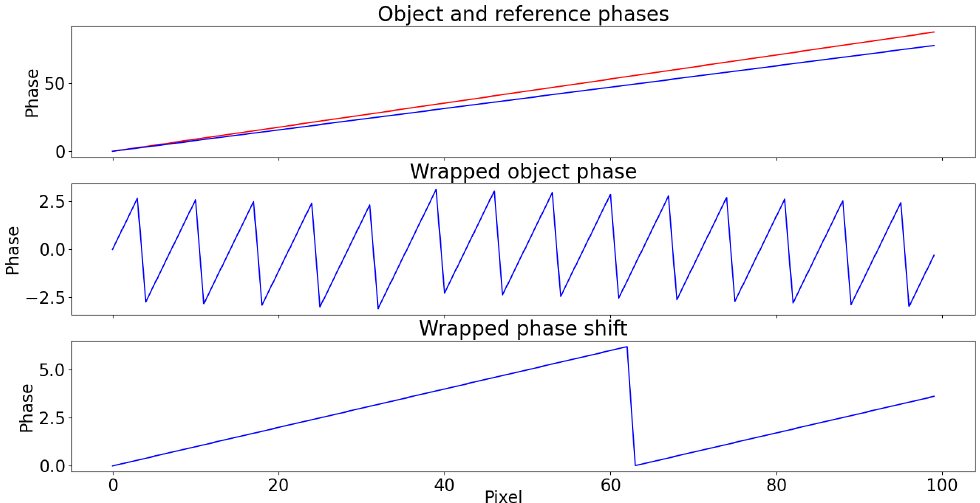
Figure 5. ( Top ) Illustrative reference Φ 0 (blue) and object Φ (red) phases. ( Middle ) The wrapped object phase Φ w presents many more 2 π -jumps compared to the ( Bottom ) wrapped phase shift ∆ Φ w